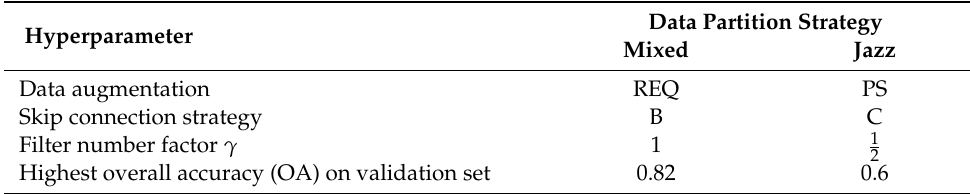
Table 4. Parameter optimization results: optimal hyperparameter configurations for both data partition